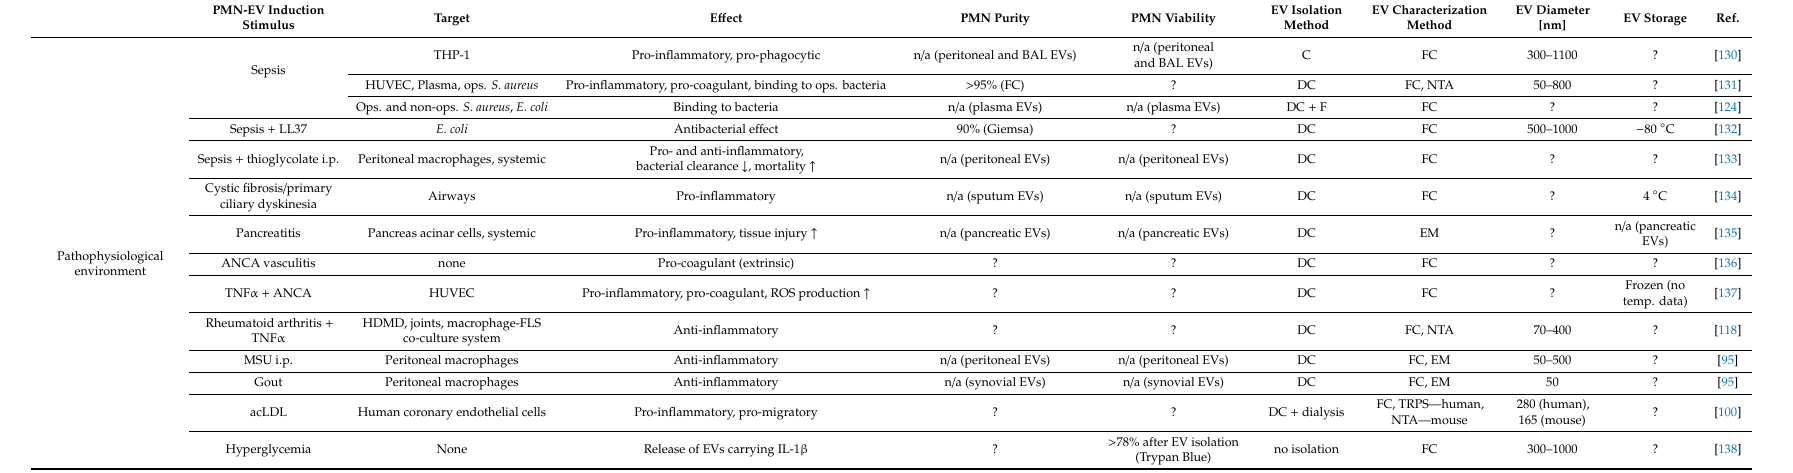
Abbreviations of Table 1. ‘?’: not communicated; n / a: not applicable; LatrB: Latrunculin B; Ops.: opsonized; MSU: monosodium urate; i.p.: intraperitoneal; HMDM: human monocyte derived macrophage; HUVEC: human umbilical vein endothelial cell; MoDC: monocyte derived dendritic cell; NK: natural killer; BMEC: brain microvascular endothelial cell; IEC: intestinal epithelial cell; PLT: platelet; ECM: extracellular matrix; P1EC: primary porcine endothelial cell; FLS: fibroblast-like synoviocyte; ROS: reactive oxygen species; EC: endothelial cell; MPO: myeloperoxidase; FC: flow cytometry; EM: electron microscopy; DLS: dynamic light scattering; NTA: nanoparticle tracking analysis; TRPS: tunable resistive pulse sensing; DC: di ff erential centrifugation; F: